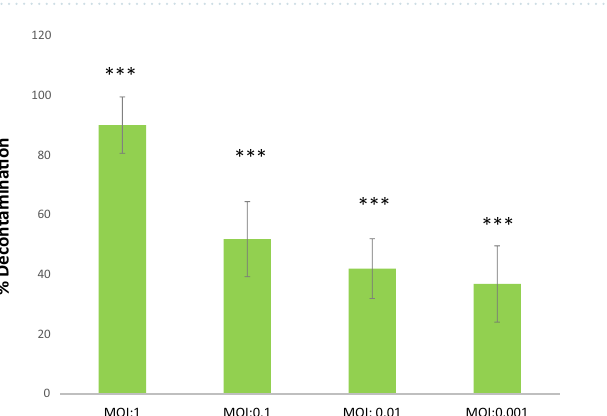
Figure 11. Stability of phage DRL-P1 under different thermal and pH conditions. ( a ) Graph showing effects of different temperature conditions on the stability of DRL-P1. Phage aliquots were incubated at different temperatures, 25 °C, 37 °C, 40 °C, 50 °C, 60 °C and 70 °C for 60 min, followed by enumeration of viable phages by standard double-layer plaque assay. Stability of phage stored at 4 °C was considered as control for comparison. Data obtained from three independent experiments are represented here as mean ± SD. *** P < 0.001 or * P < 0.05 indicates a significant reduction at temperature 60 °C & 70 °C in comparison to initial PFU count. ( b ) Graph showing effects of different pH conditions on the stability of phage DRL-P1. Aliquots of phage were added to buffers adjusted to various pH conditions (1.0–14.0), incubated at room temperature for 18 h, followed by enumeration of viable phages by standard double-layer plaque assay. Data obtained from three independent experiments are represented here as mean ± SD. *** P < 0.001, ** P < 0.01 or * P < 0.05 indicates a significant reduction level at pH 3, 4, 5, 10, 11 &12 in comparison to initial PFU count (as compared to phage stored in TM buffer pH 7.4 at 4 °C). Plots were generated using the chart function incorporated in Excel program (MS Office version 18.2106.12410.0) and statistical analysis were performed using the GraphPad PRISM computer program (Trial version 7.05; https:// www. graph pad. com/ scien tific- softw are/ prism/).